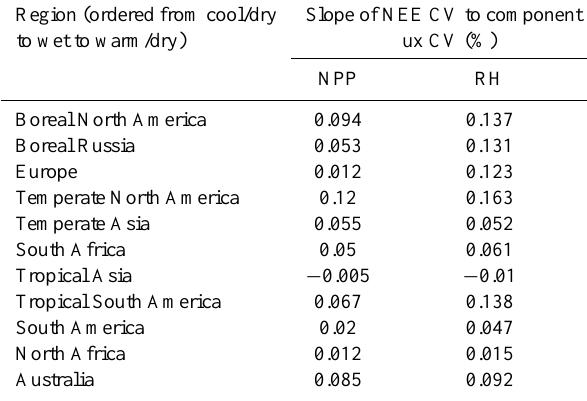
Table 4. Sensitivity (slope of linear regression) of the uncertainty of net ecosystem exchange, expressed as coefficient of variation (CV), to the uncertainty of net primary production and heterotrophic respi- ration component fluxes (CV). The analysis was conducted on area aggregated fluxes that corresponded TransCom3 regions (Fig. 1). The uncertainty of NEE in northern regions is mainly controlled by RH uncertainty (implying greater temperature sensitivity of soil respiration), whereas in topical and arid regions, NPP and RH un- certainty are equally important.